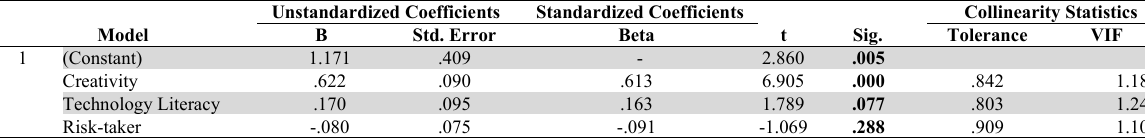
Coefficients Regression of Y against X 1 , X 2, and X 3 Model